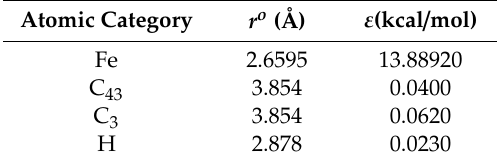
Table 1. Parameters of LJ potential in COMPASS